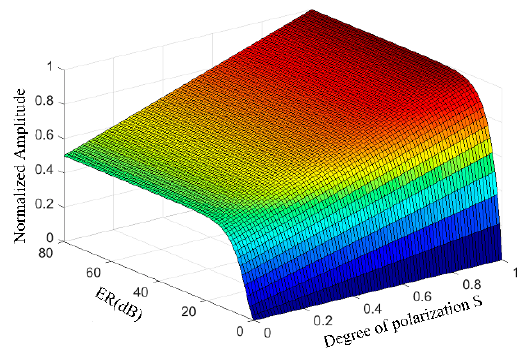
Figure 3. The influence of polarizer degree ( S ) and extinction ratio ( ER ) on the normalized amplitude of the AC component where ER = − 10 lg μ 2 .